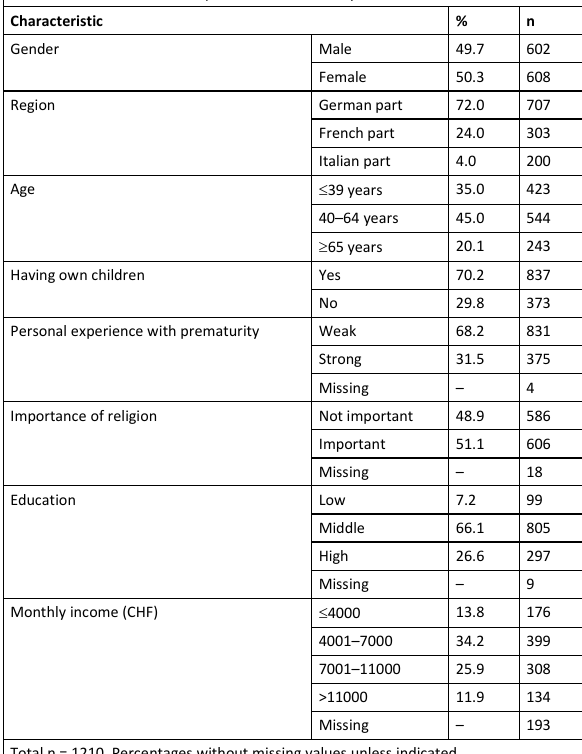
Table 1: Characteristics of respondents in the